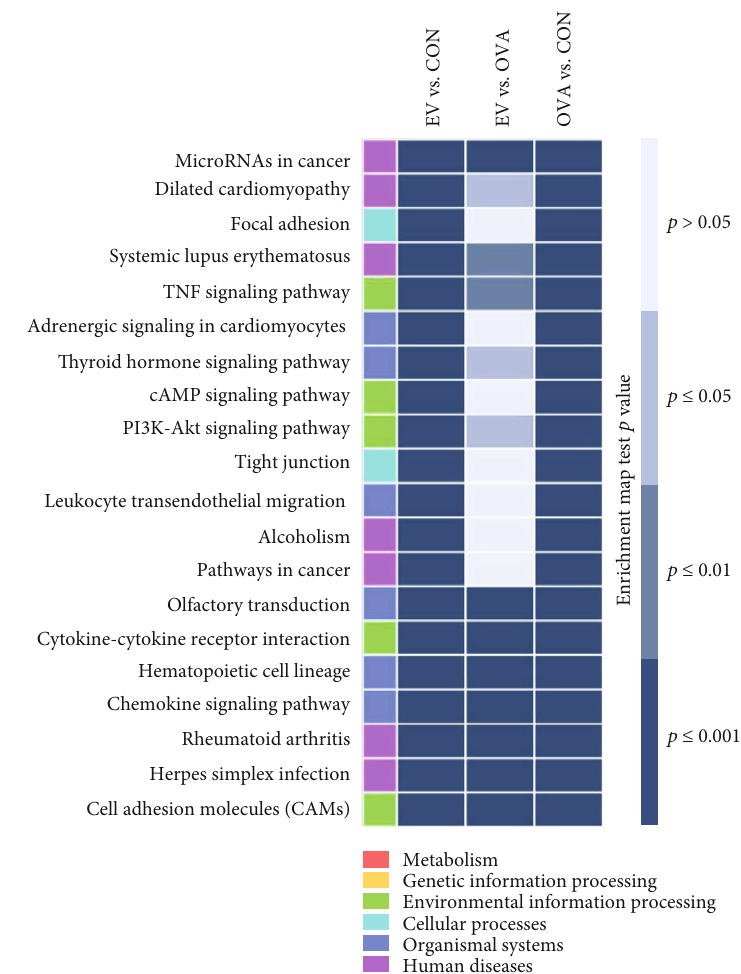
Figure 7: Enrichment analysis based on the Kyoto Encyclopedia of Genes and Genomes (KEGG) pathway identi fi ed genes with signi fi cantly di ff erential expression. DEGs were strongly associated with environmental information processing, organismal systems, and human diseases. The expression of PON1, Bex2, Igfbp6, and Scgb1c1 was signi fi cantly increased following treatment with ASC-derived EVs in asthmatic mice. Gene ontology analysis showed that these upregulated genes were mainly involved in immune system processes and their regulation, cellular and single-organism processes, and biological regulation. These altered genes may be involved in the amelioration of allergic airway in fl ammation through treatment with ASC-derived